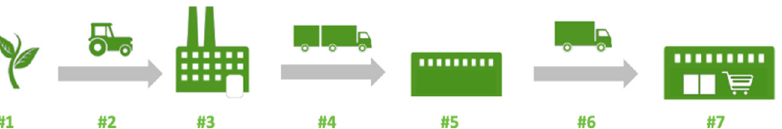
Figure 1. Sample supply chain. #1: raw material supplier, #2: single-drop transport from the supplier to the producer, #3: producer (with raw material and finished product warehouses), #4: single-drop transport from the producer to the distribution center, #5: distribution center, #6: multidrop transport from the distribution center to the retailer, #7: retailer (with a backroom warehouse and a display area).